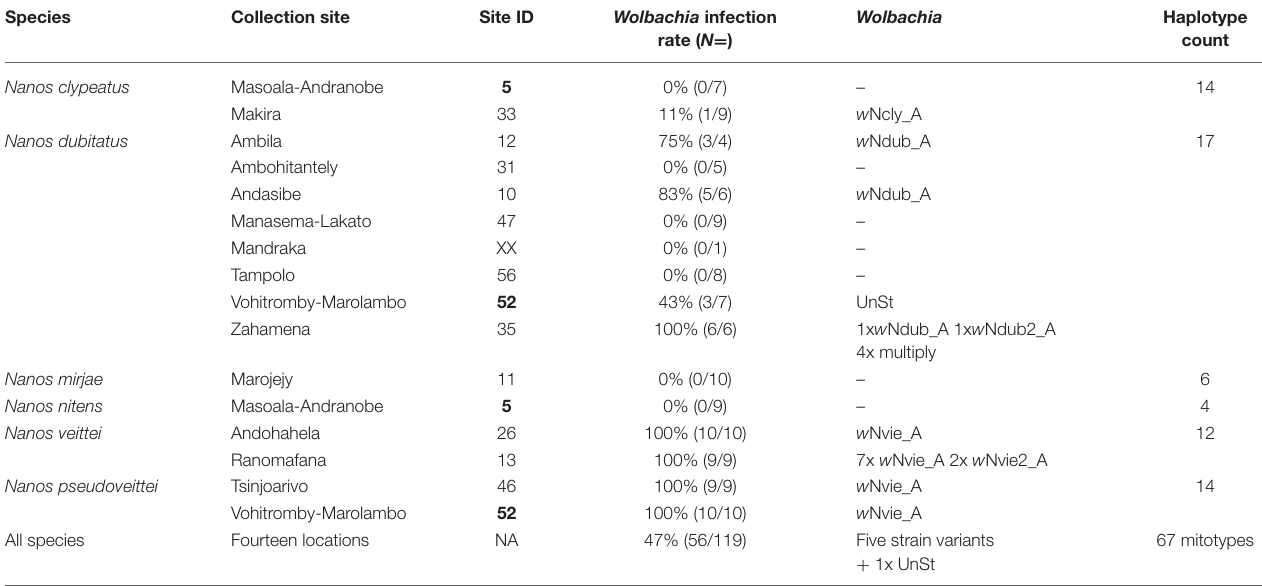
TABLE 1 | Species, sample size, and Wolbachia infection status at each collection site.